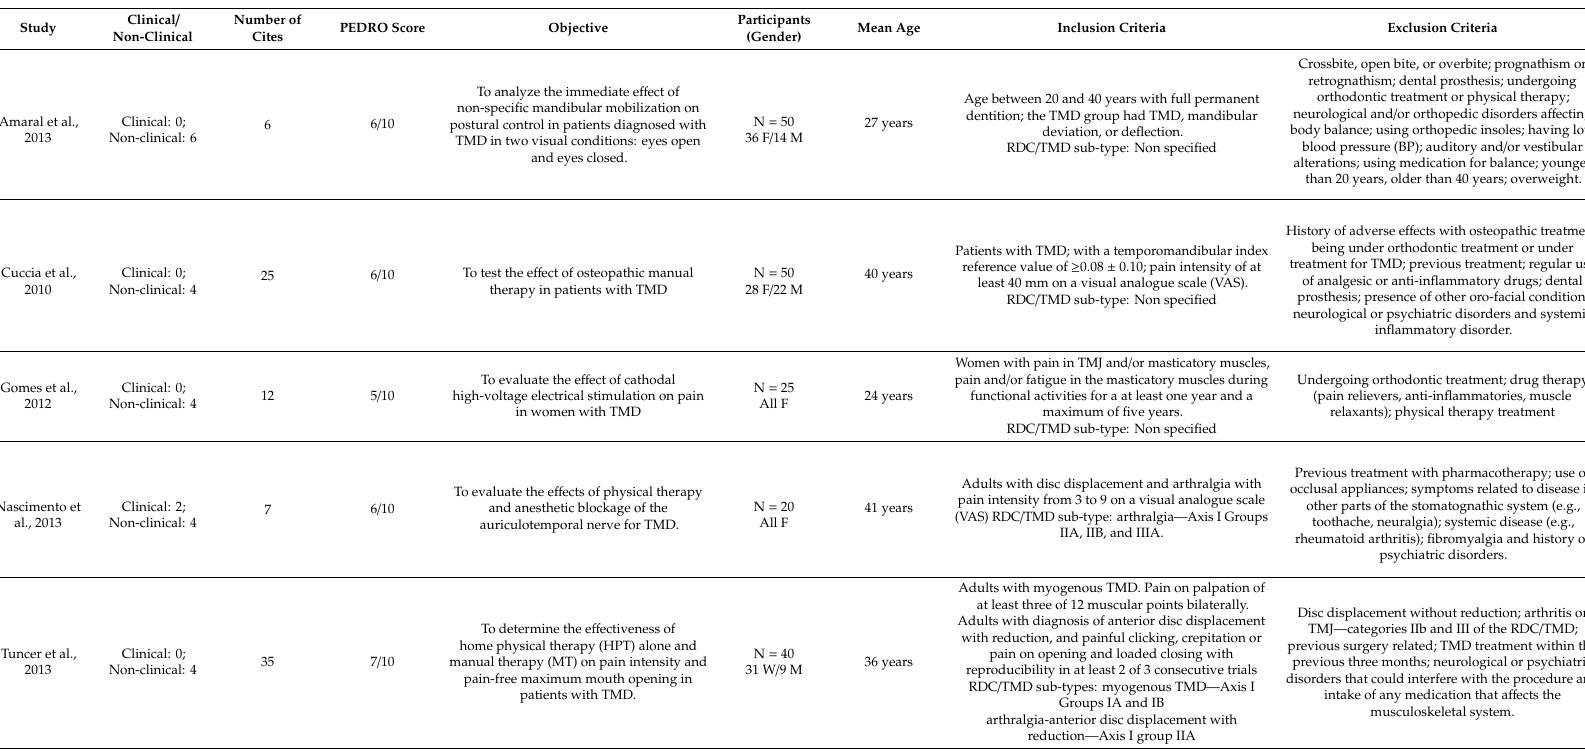
Table 1. Characteristics of clinical trials including patients with temporomandibular disorders according to the citation criteria. F—Female; M—Male; TMD—Temporomandibular disorders; TMJ—Temporomandibular joint; RDC / TMD—Research Diagnostic Criteria for Temporomandibular disordes; VAS—visual analoge